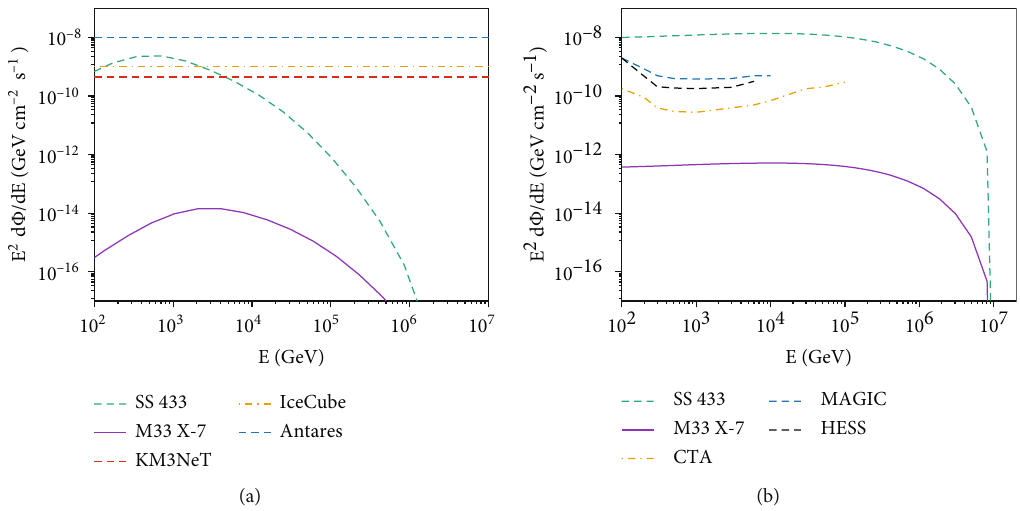
Figure 7: Di ff erential neutrino fl uxes (a) and gamma-ray fl uxes (b) weighted over the energy squared E 2 d Φ / dE for the M33 X-7 (solid lines) and SS 433 (dashed lines). They are compared with the corresponding sensitivities of the neutrino detectors (a) ANTARES [54], IceCube [55], and KM3NeT [56] and the respective gamma-ray sensitivities (b) from MAGIC and HESS telescopes as well as the foreseen sensitivity of the next-generation Cherenkov Telescope Array (CTA) [57].